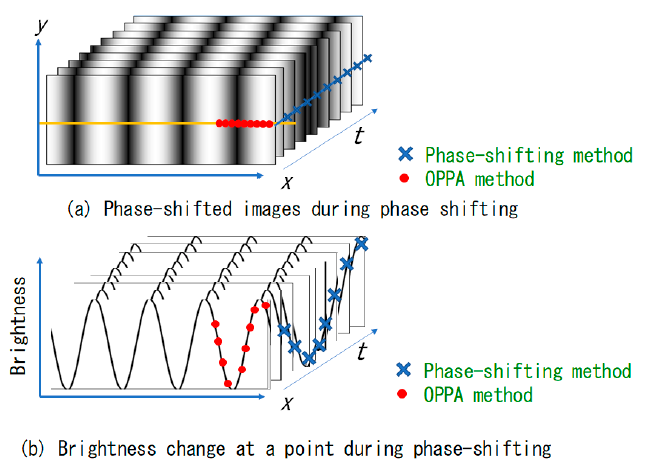
Figure 2. Comparison of phase analysis methods between phase-shifted images and brightness distributions [17].